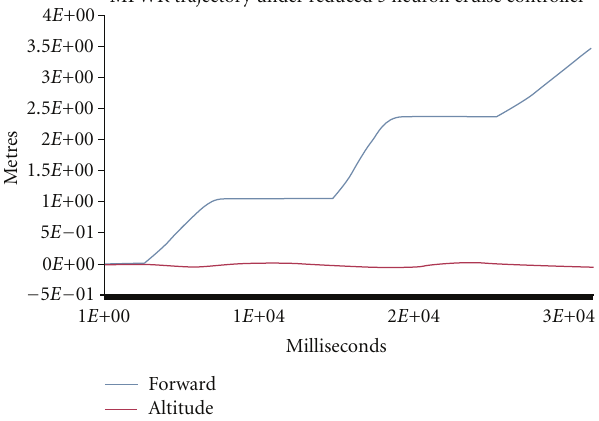
Figure 16: The MFWR trajectory produced by the reduced five neuron controller. It can be observed that the architectural reduced controller was successful in producing qualitatively same cruise behavior possible by the fully connected eight neuron network. The MFWR trajectory produced by the eight-neuron network is shown in Figure